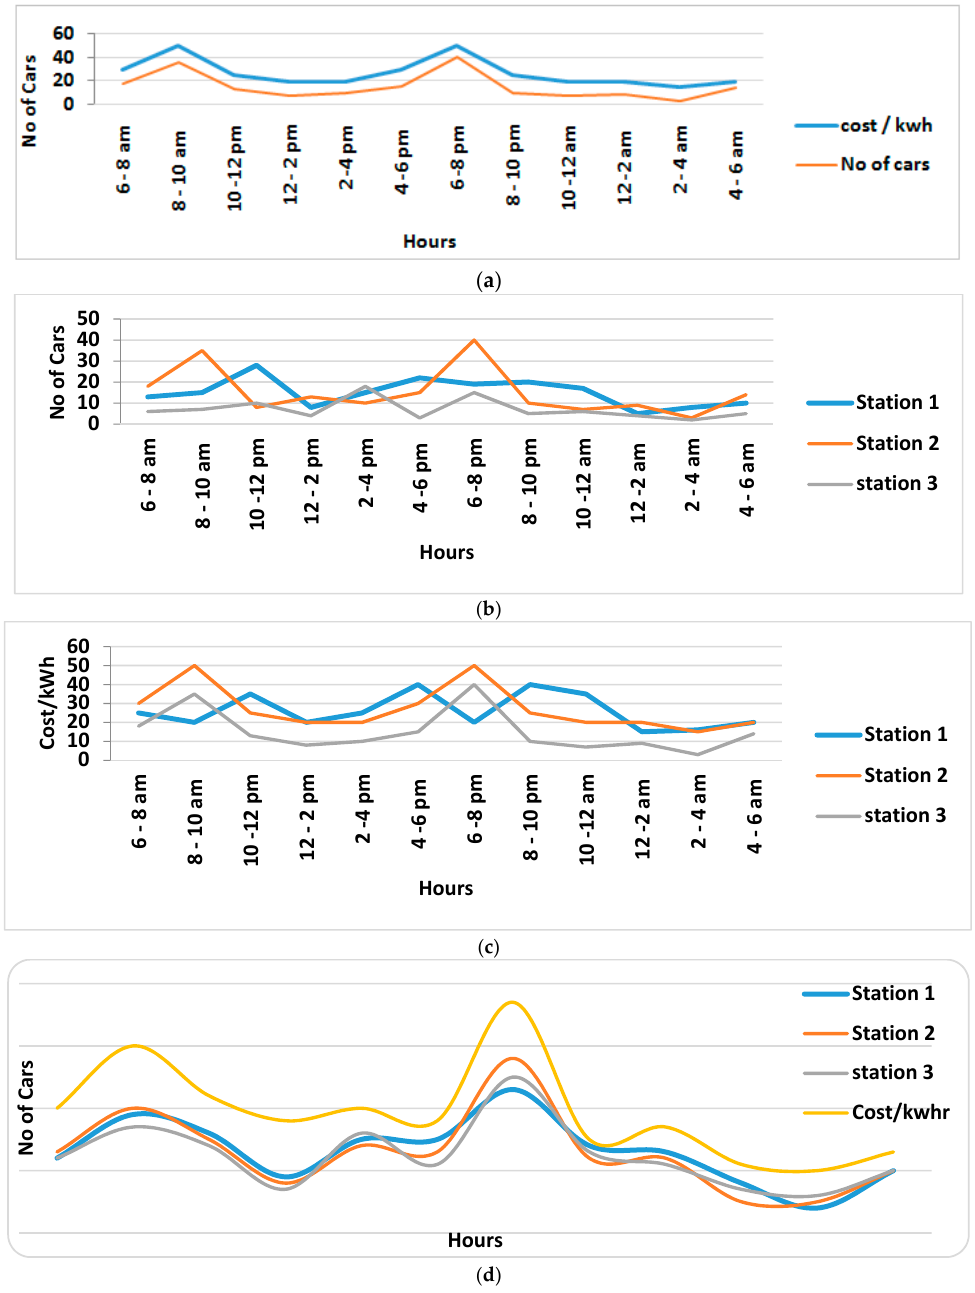
Figure 3. ( a ) The increase in cost/kWh as the number of vehicles increases; ( b ) Peak demands at three different stations; ( c ) Cost per kWh of charging in three different stations; ( d ) Stabilized peak demand and cost per kWh in all three stations.